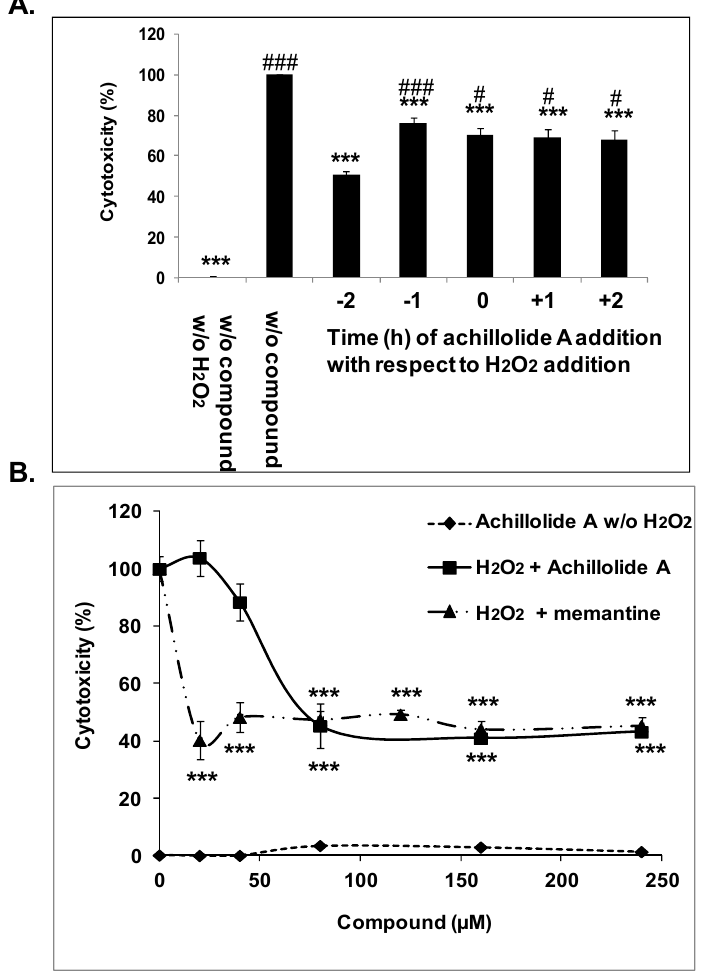
Figure 1. Protective effect of achillolide A on astrocyte cell death induced by H 2 O 2 . ( A ) Achillolide A (80 μ M) was added to astrocytes before ( − 2 h, − 1 h) concomitant (0) or after (1 h, 2 h) the addition of H 2 O 2 (175 μ M). Cytotoxicity was measured 20 h later by the levels of LDH in the conditioned media. Results are means ± SEM of two experiments ( n = 8). # p < 0.05, ### p < 0.001, compared to cells that were